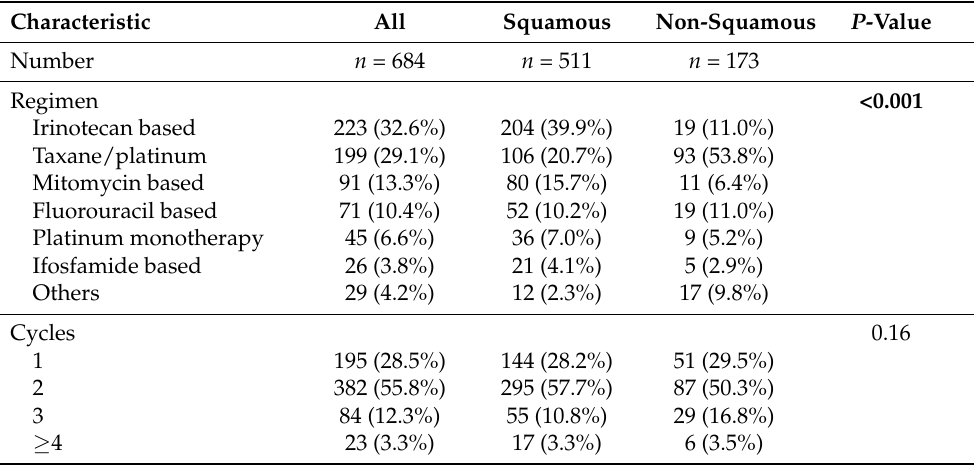
Table 1. Type and cycle of neoadjuvant